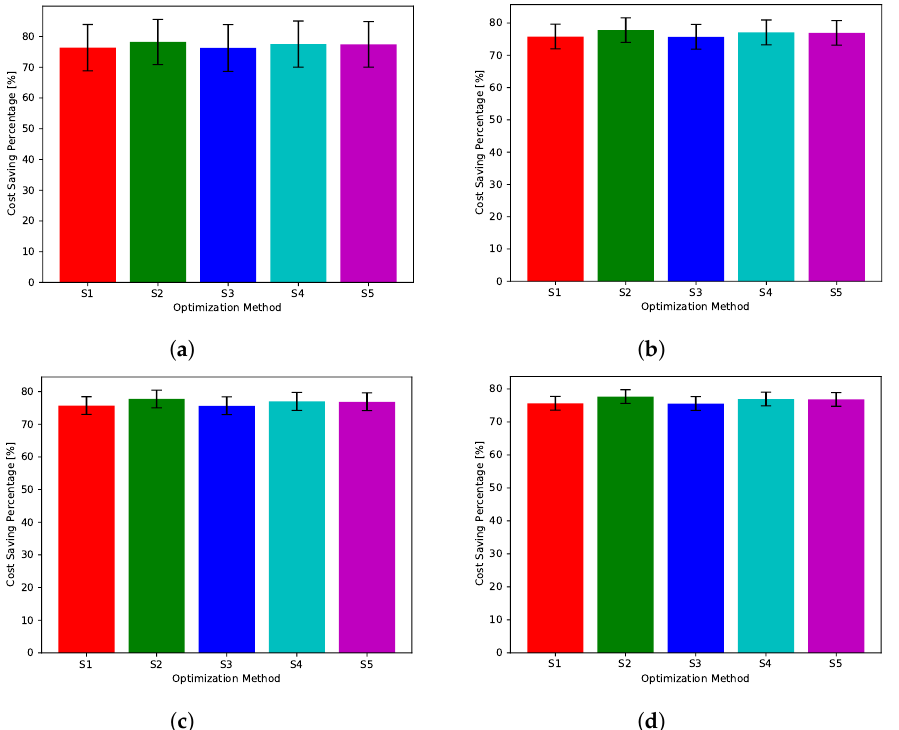
Figure 24. The total cost saving achieved by the proposed greedy scheduler when compared with scheduling policies fixed uncertainty level U 25 . ( a ) Monthly, ( b ) quarterly, ( c ) semiannually, and ( d ) annually.